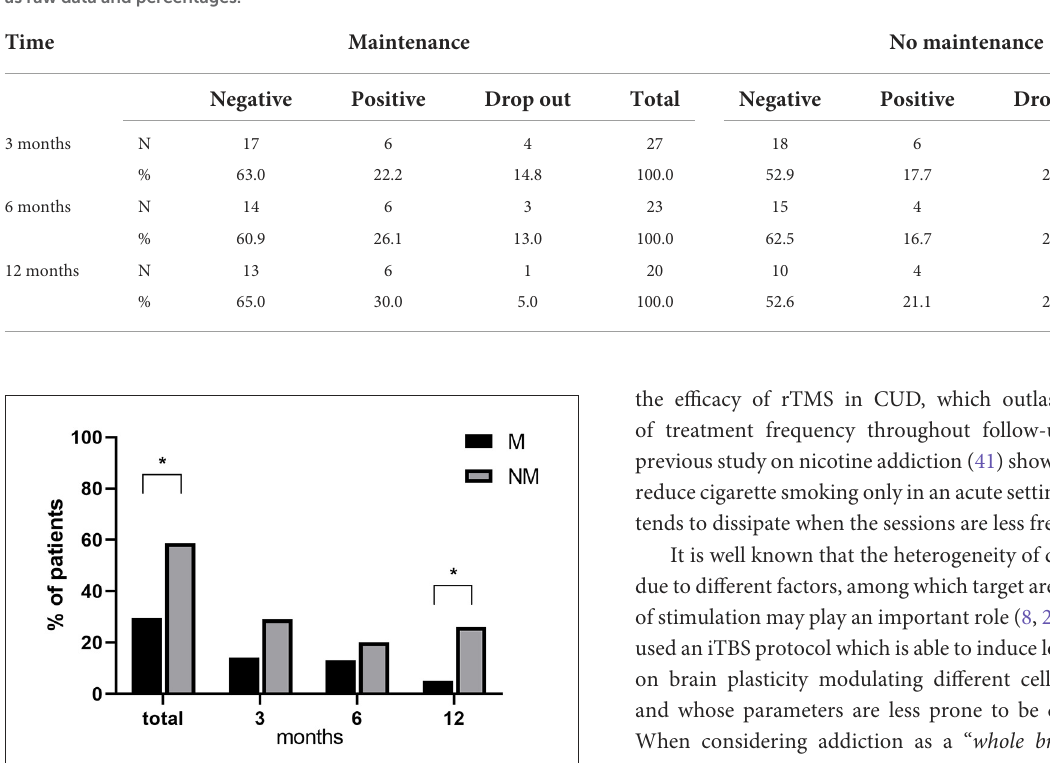
TABLE 2 Cocaine positive and negative patients at 3, 6 and 12 months of follow up in maintenance and no-maintenance group. Data are expressed as raw data and percentages.